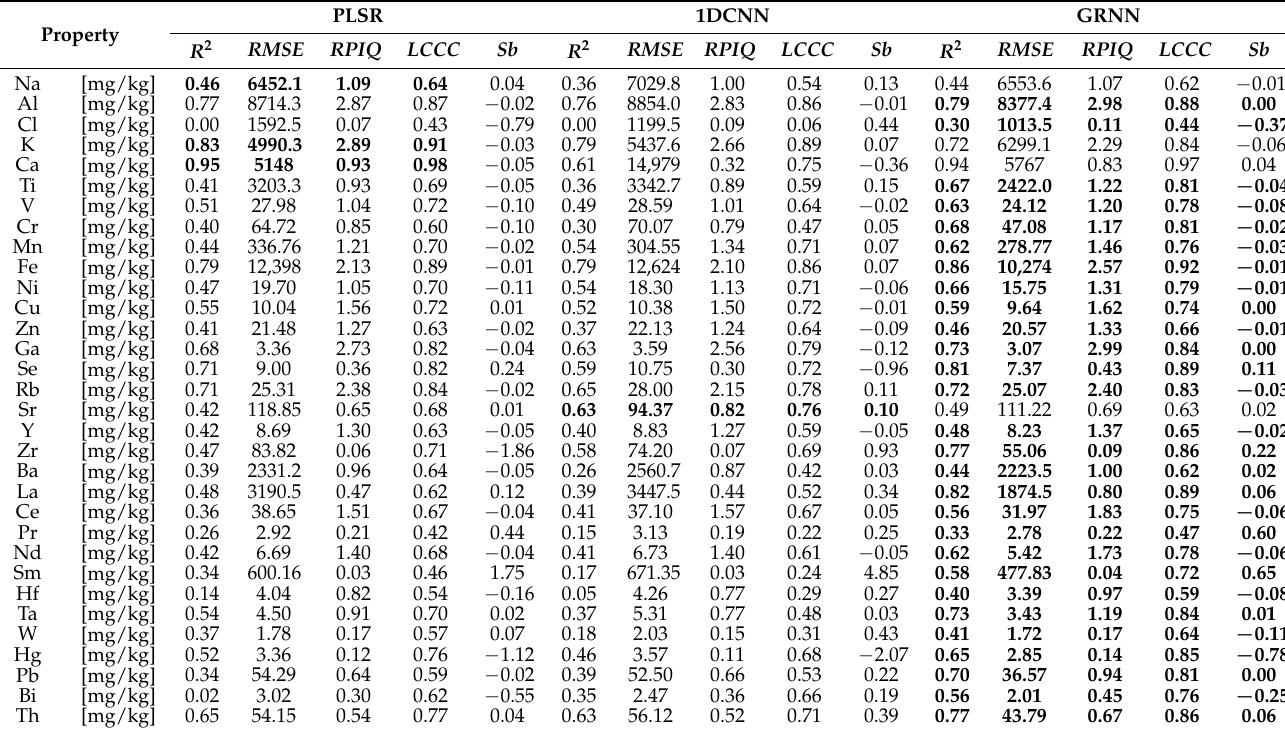
Table 4. Summary of model validation statistics for the “Elements” group. The best prediction result for particular variables is marked in